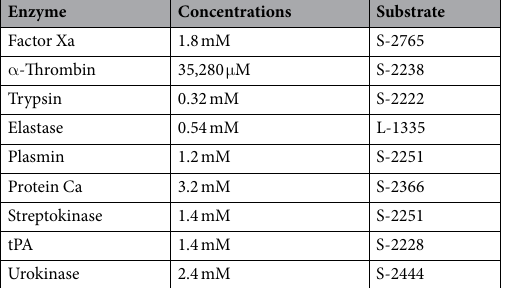
Table 3. Final concentrations of enzymes and substrates used in Ki determinations.